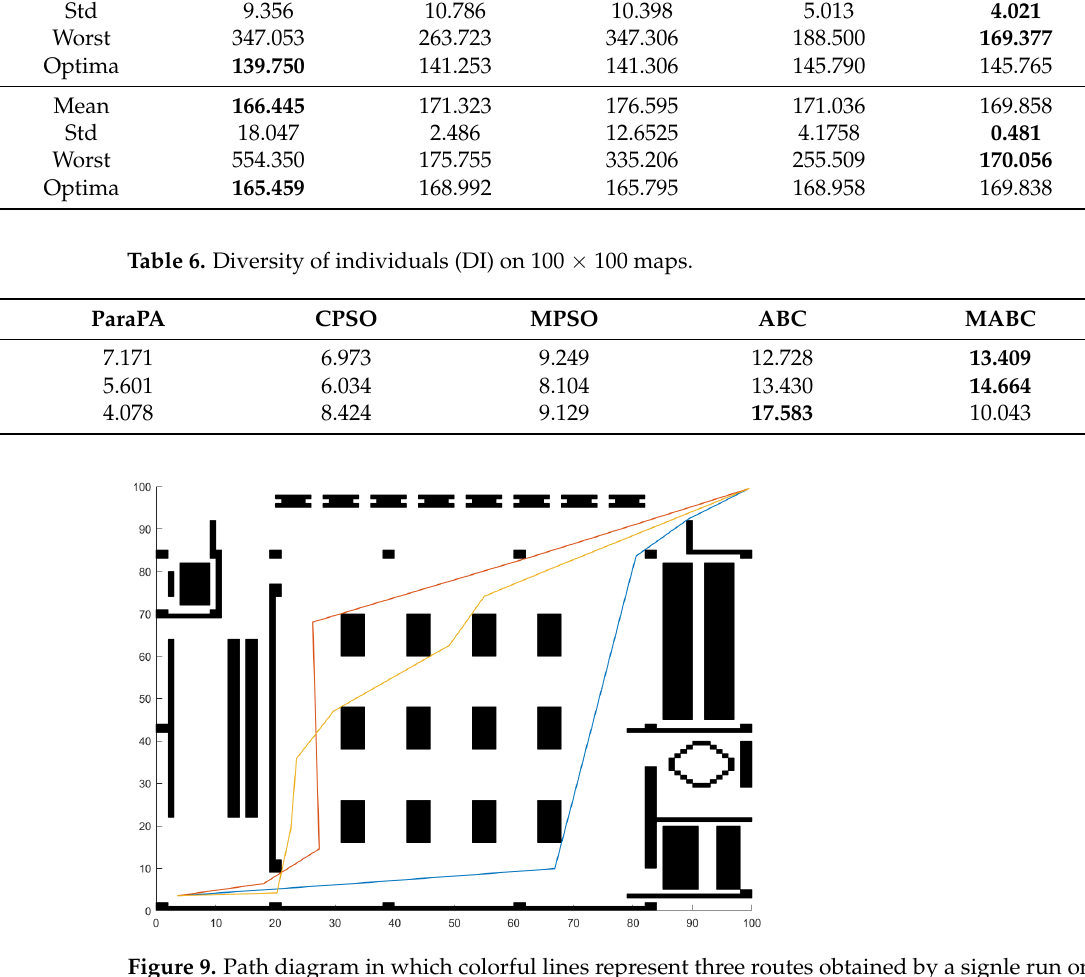
Figure 9. Path diagram in which colorful lines represent three routes obtained by a signle run on a 100 × 100